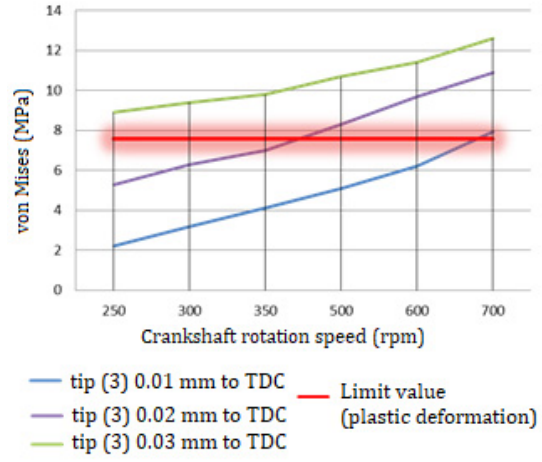
Figure 17. Dependence of the stress values on the crank– shaft speed at different depths of the tip towards the